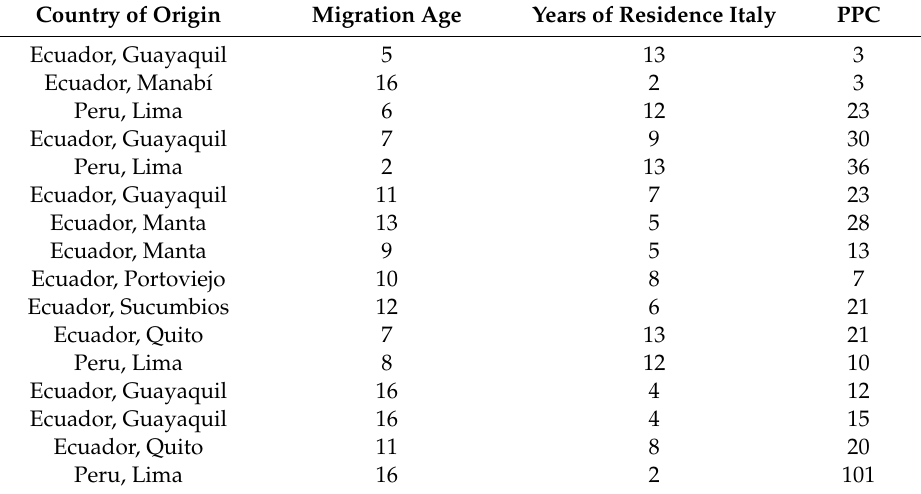
Table 1. Characteristics of the interviewees and number of occurrences in the PPC.